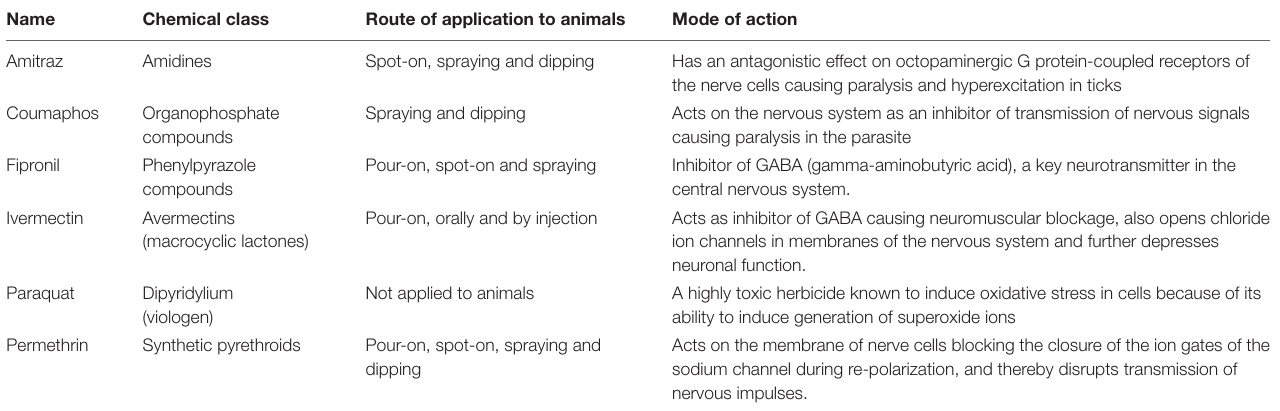
TABLE 2 | Acaricides and pesticides used with tick cell lines in studies on tick control reviewed in this